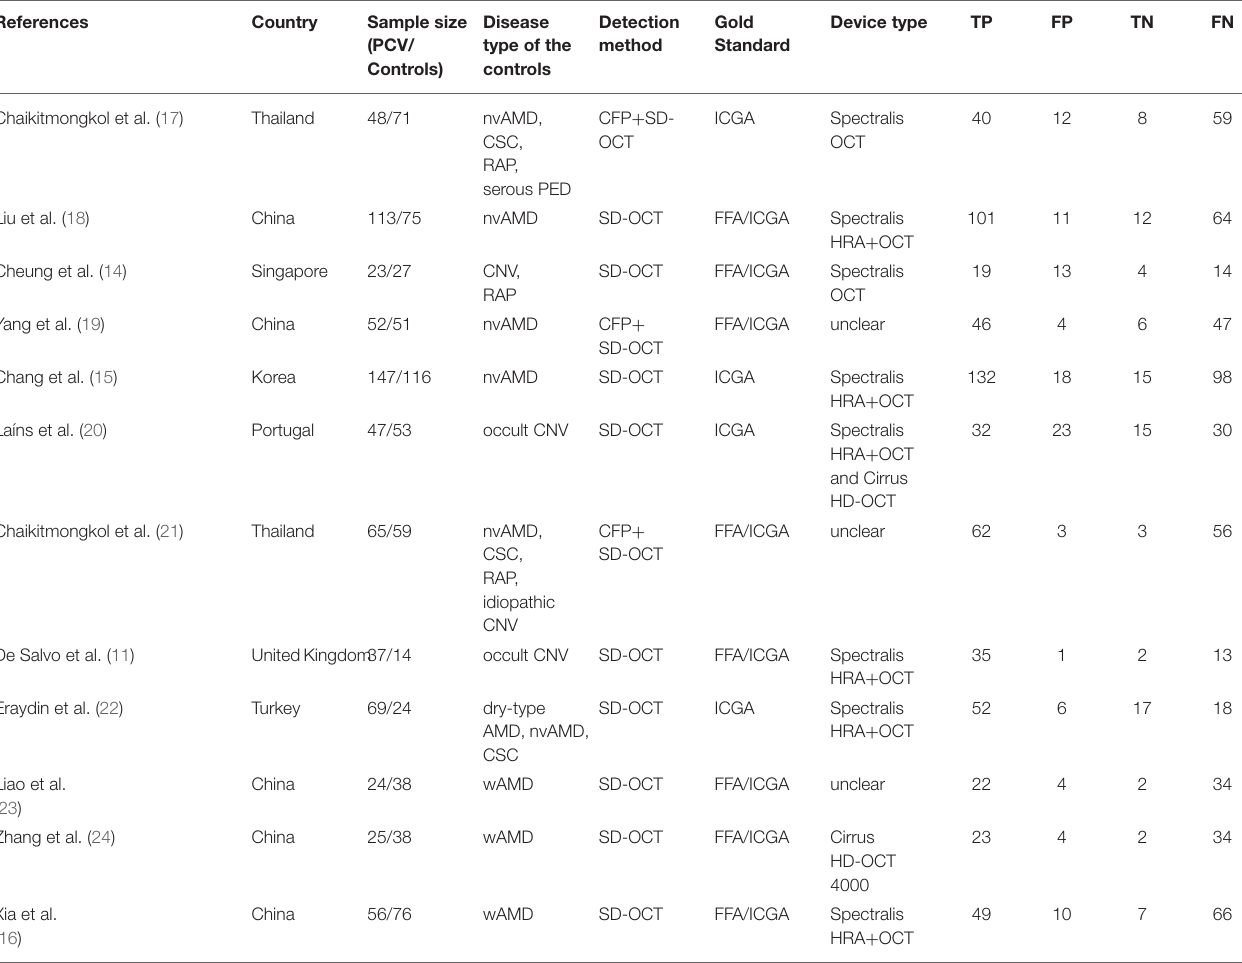
TABLE 1 | Characteristics of the included studies ( n = 12).